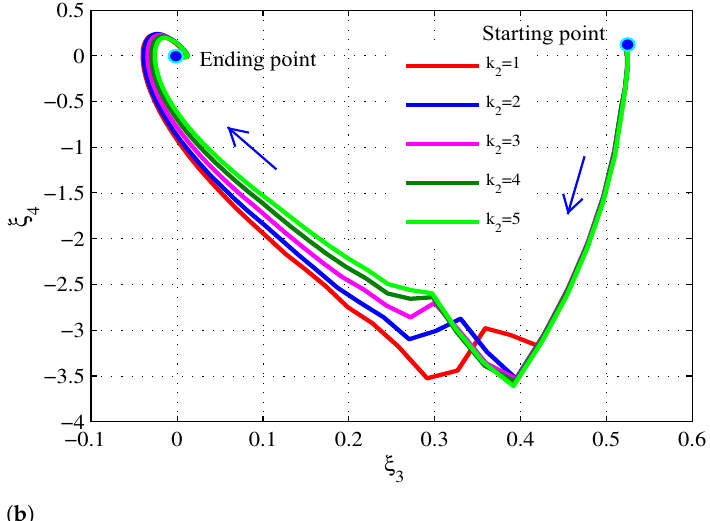
Figure 3. The phase portraits of the zero dynamics with different control parameters. ( a ) k 2 = 1; and ( b ) k 1 = 8.